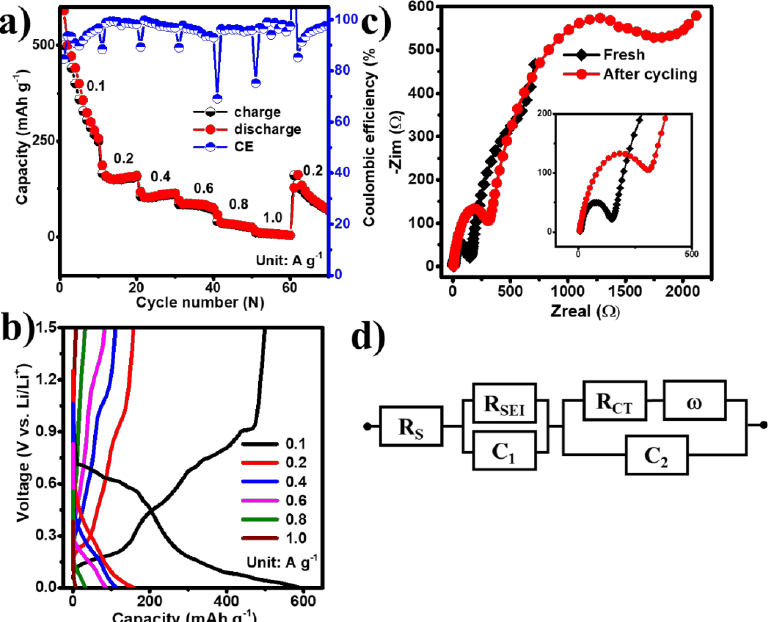
Figure 6. The ( a ) rate performance test, ( b ) typical voltage profiles at different current densities, ( c ) EIS spectra, and ( d ) corresponding equivalent circuit model. Table 1. EIS results extracted using the equivalent circuit in Figure 6d.